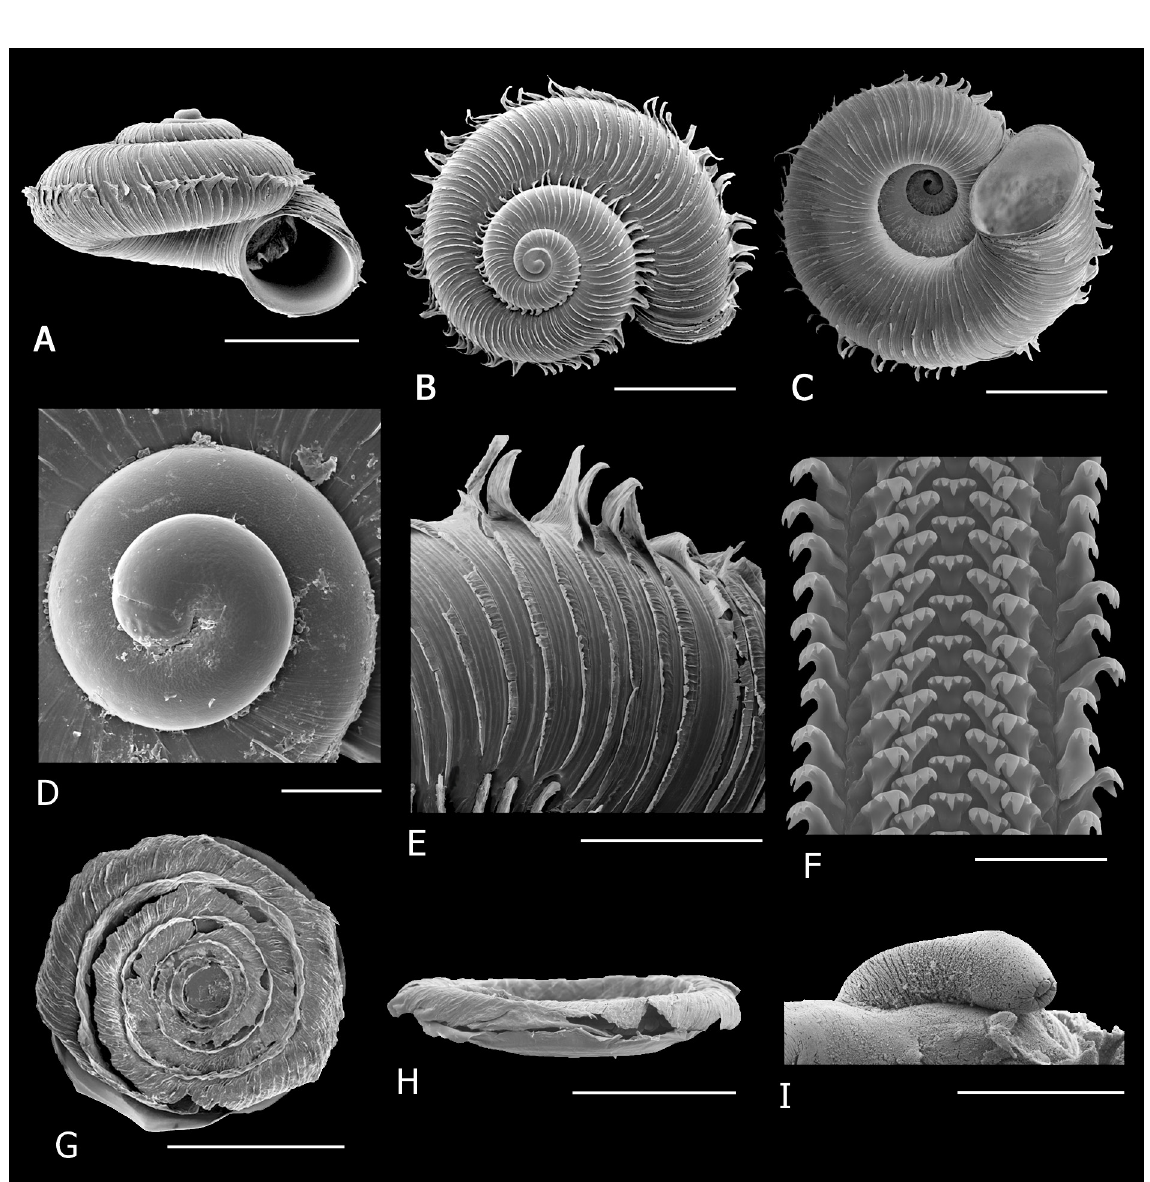
Fig. 13. Chondrocyclus silvicolus sp. nov. A . Aperture view (ELM D16963/T45). B . Dorsal view (ELM D16963/T45). C . Ventral view (ELM D16963/T45). D . Protoconch (ELM W3644/T46). E . Detail of axial lamellae of periostracum (ELM D16963/T45). F . Portion of radula (ELM D16963/T45). G–H . Operculum (ELM W3644/T46). I . Penis, lateral view (ELM W3644/T46). Scale bars: A–C = 2 mm; D = 200 µm; E, G–I = 1 mm; F = 50 µm.